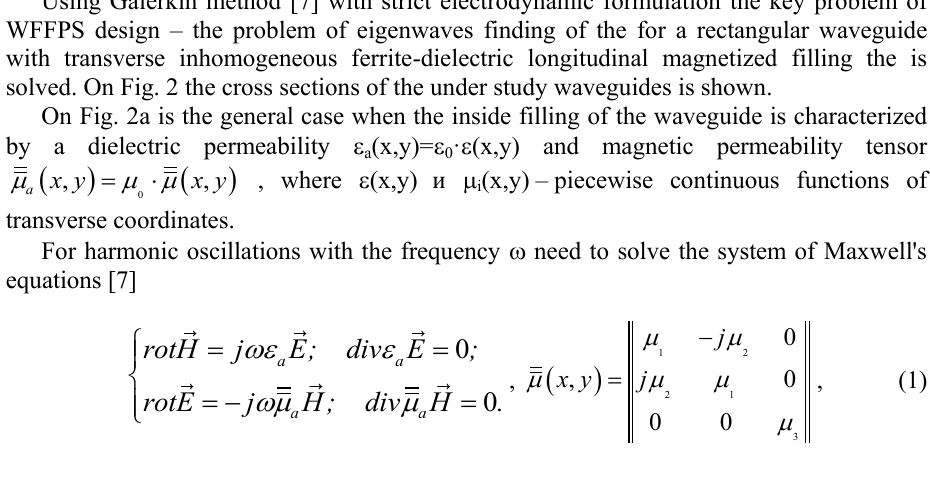
Fig. 1. Waveguide ferrite Faraday phase shifter